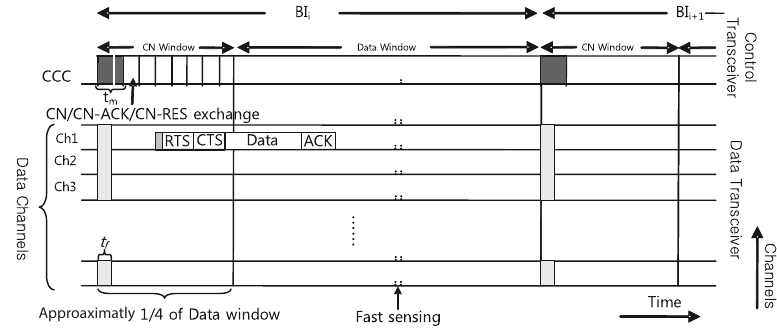
Figure 5. P-MAC time-channel domain structure. RES,